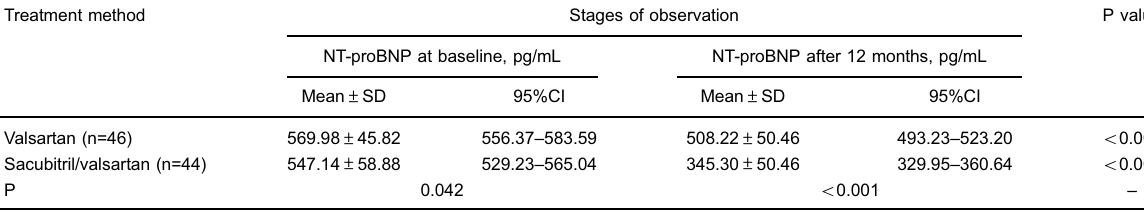
Table 4. Changes achieved in the primary endpoint in patients who completed the study. Treatment